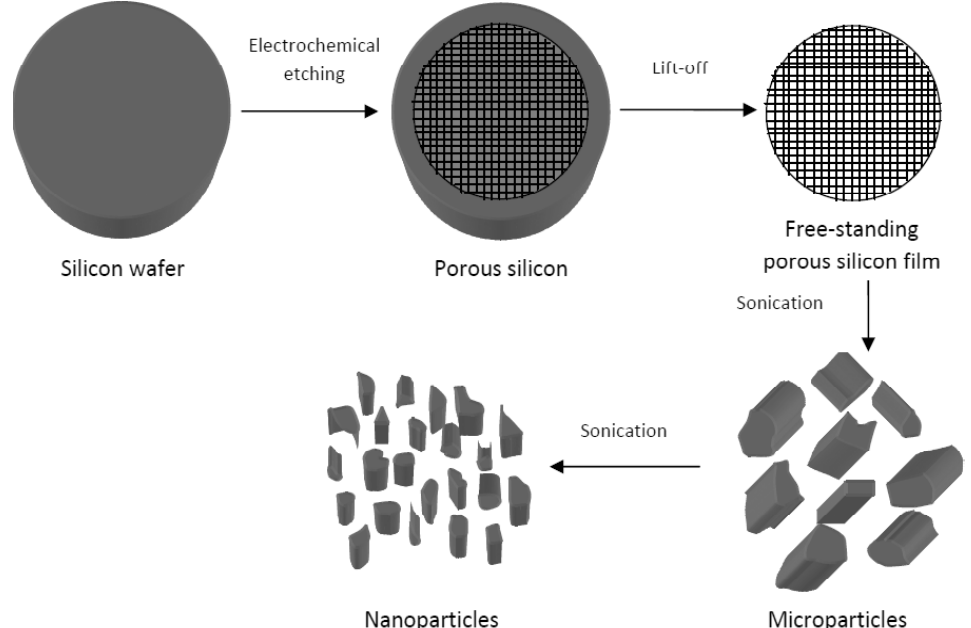
Fig. 6. Schematic diagram of PSi micro and nanoparticles preparation by ultrasonic fracture of freestanding